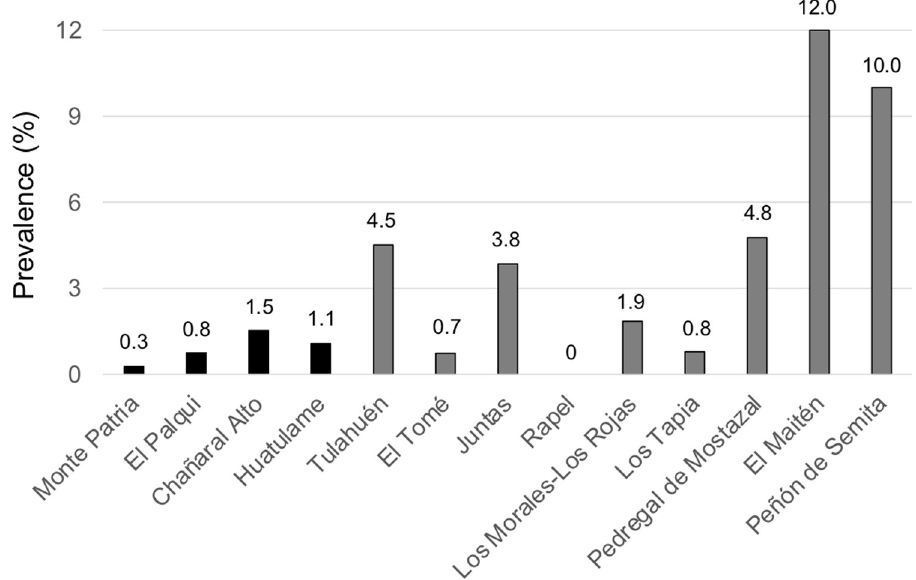
Fig 3. Prevalence of abdominal cystic echinococcosis according to the locality of residence in the Monte Patria municipality, Limarı´province, Coquimbo region, Chile.